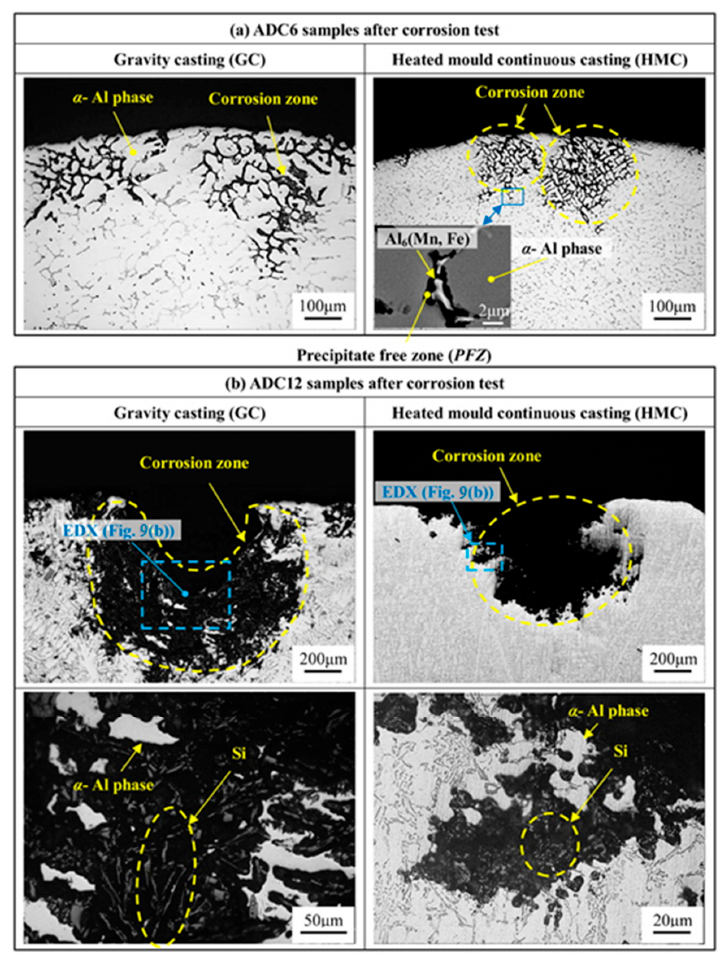
Figure 10. Optical micrographs of cast aluminum alloys after corrosion tests: ( a ) ADC6 samples obtained by gravity casting and heated mould continuous casting ( b ) ADC12 samples obtained by gravity casting and heated mould continuous casting. Reprinted with permission of [23].